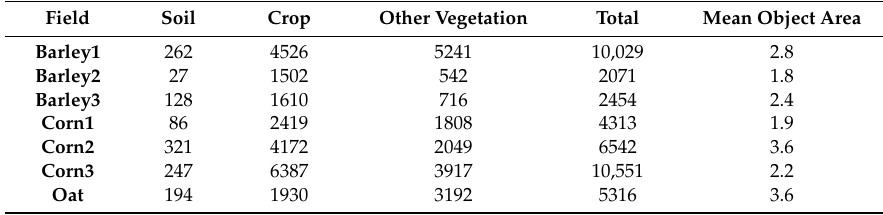
Table 6. Number of training objects per class for GEOBIA and their mean object area (m 2